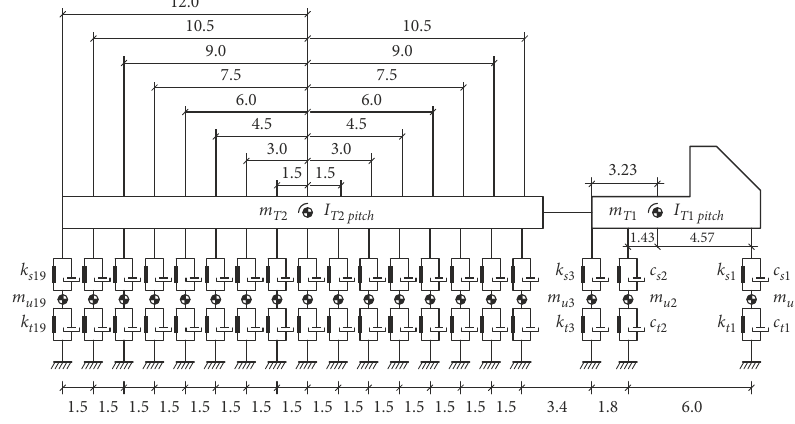
Figure 1. Side view of 19-axle vehicle (all dimensions in meters) Table 1. Properties of the 19-axle long vehicle ( R and L refer to right and left wheel respectively) Symbol Property Value Units m T 1 Tractor body mass 15 100 kg m T 2 Trailer body mass 147 400 kg 350